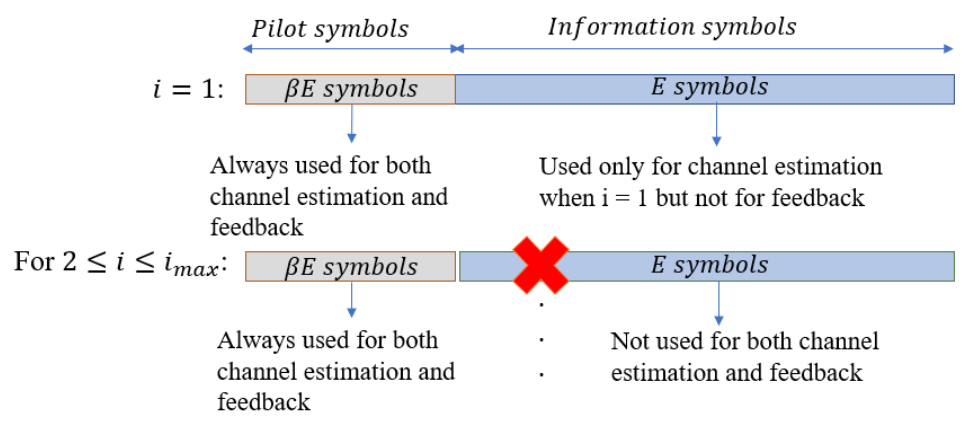
Figure 4. Graphical presentation for the joint iterative semi-blind scheme